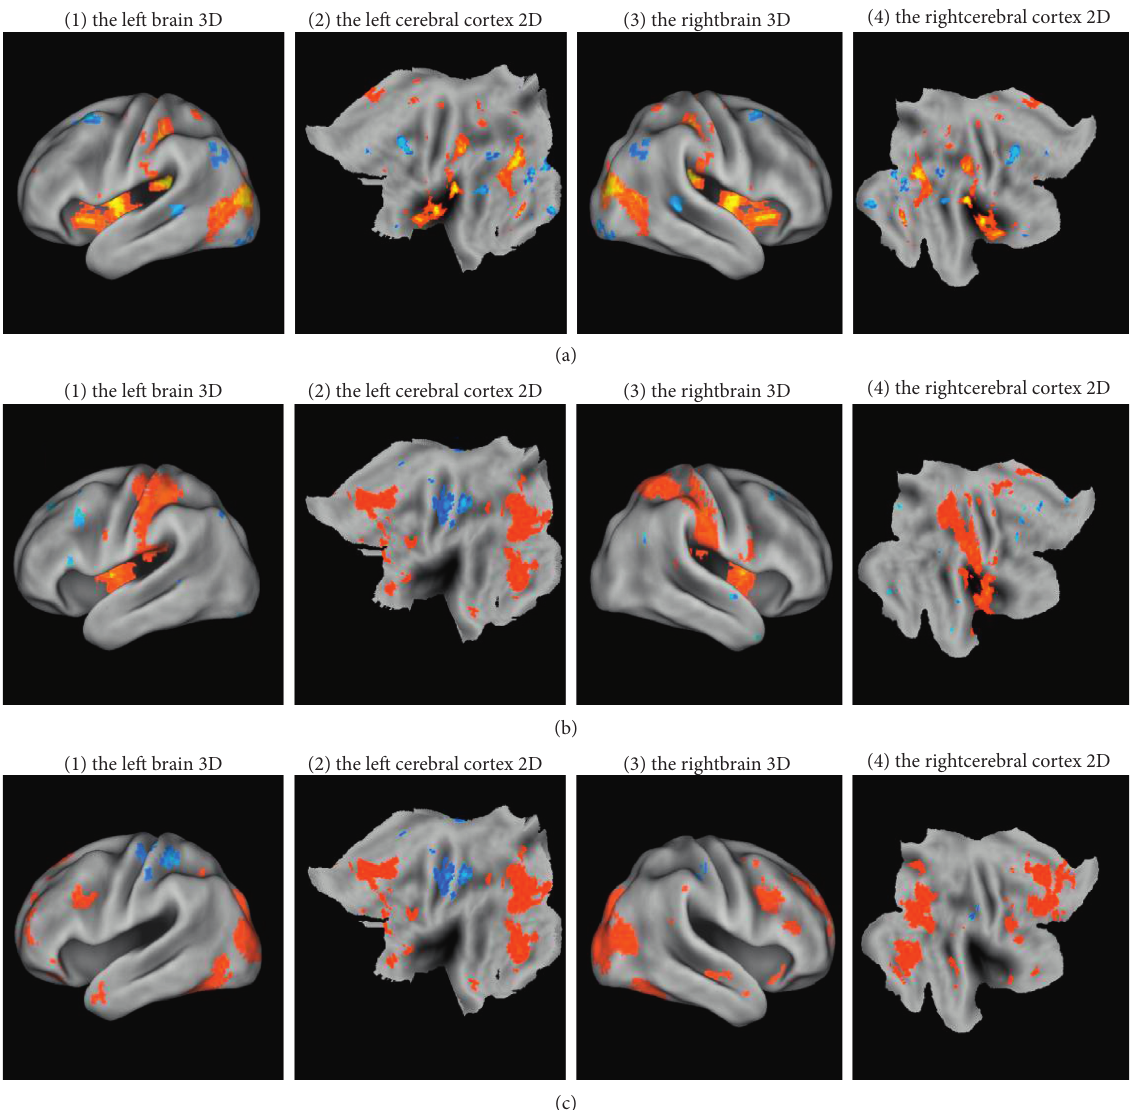
Figure 3: Functional activation 3D maps of left and right brain obtained for the novel (a), target (b), and target-novel contrast (c). (a) Brain regions showing activity to the novel stimuli. (b) Brain regions showing activity to the target stimuli. (c) Brain regions showing activity to the novel-target contrast. Reported activation became all thresholds at p < 0 . 001 uncorrected. Gray reflects the background baseline state of the cerebral cortex; the darker the color, the closer to orange-red, indicating that the increased rate of blood oxygen concentration in the brain area is more significant, indicating that the area is being activated. The lighter the color, the closer to blue, which means that the rate of decrease in blood oxygen concentration in this brain area is more significant, indicating that this area is negatively activated. a1: in the new heterostimulus task state, the activation area of the left brain 3D model; a2: in the new heterostimulus task state, the activation area of the 2D model of the left cerebral cortex; a3: in the new heterostimulus task state, the activation area of the right brain 3D model; a4: in the new heterostimulus task state, the activation area of the 2D model of the right cerebral cortex; b1: in the target stimulation task state, the activation area of the left brain 3D model; b2: in the target stimulation task state, the activation area of the 2D model of the left cerebral cortex expanded; b3: in the target stimulation task state, the activation area of the right brain 3D model; b4: in the target stimulation task state, the activation area of the 2D model of the right cerebral cortex; c1: for fMRI image data, using target stimulation-new stimulation, the activation area of the left brain 3D model; c2: for fMRI image data, using target stimulation-differential stimulation, the activation area of the 2D model of the left cerebral cortex; c3: for fMRI image data, use target stimulation-new stimulation, the activation area of the right brain 3D model; c4: for fMRI image data, using target stimulation-differential stimulation, the activation area of the 2D model of the right cerebral